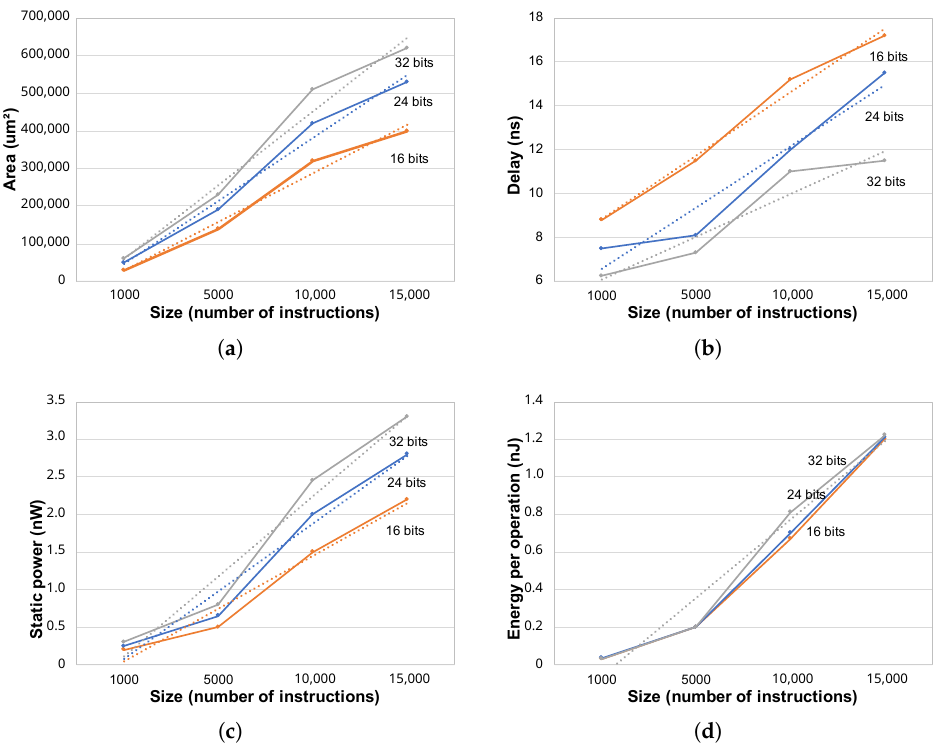
Figure 5. Program memory characterization in terms of memory size for different instruction lengths (16, 24, and 32 bits). Trend lines (dotted) indicate the linear regression used for modeling the behavior of the characteristics. ( a ) Area. ( b ) Delay. ( c ) Static power. ( d ) Energy per operation.